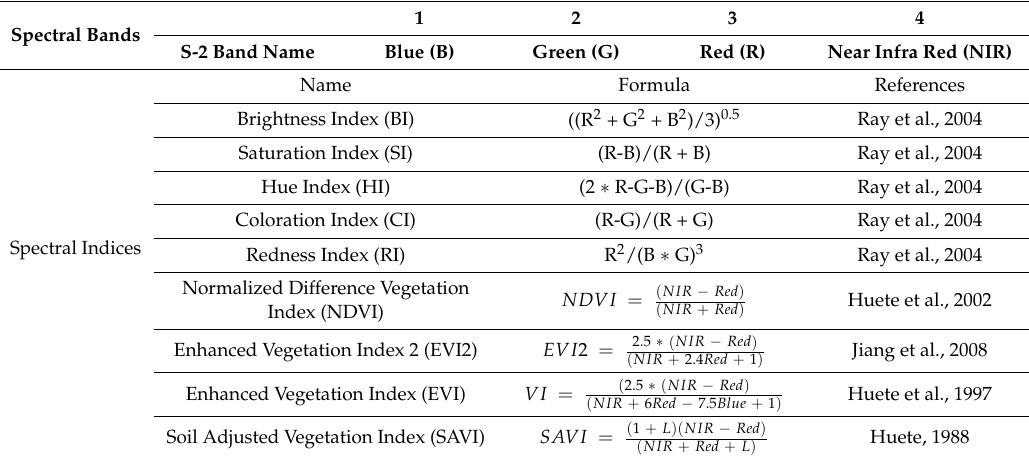
Table 1. Spectral bands, soil and vegetation indices derived from the S-2 data.